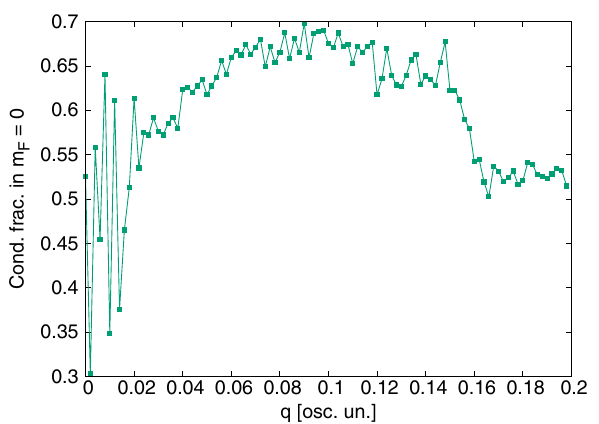
0.15 (cid:31) ω x ) and B =